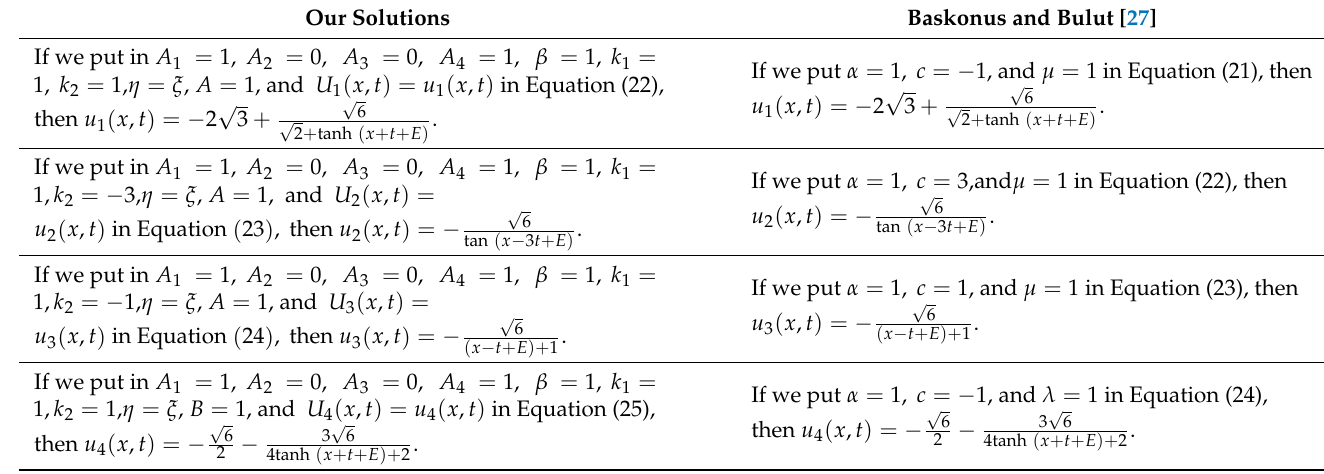
Table 1. Comparison between our solutions and Baskonus and Bulut [27] solutions. Our Solutions Baskonus and Bulut